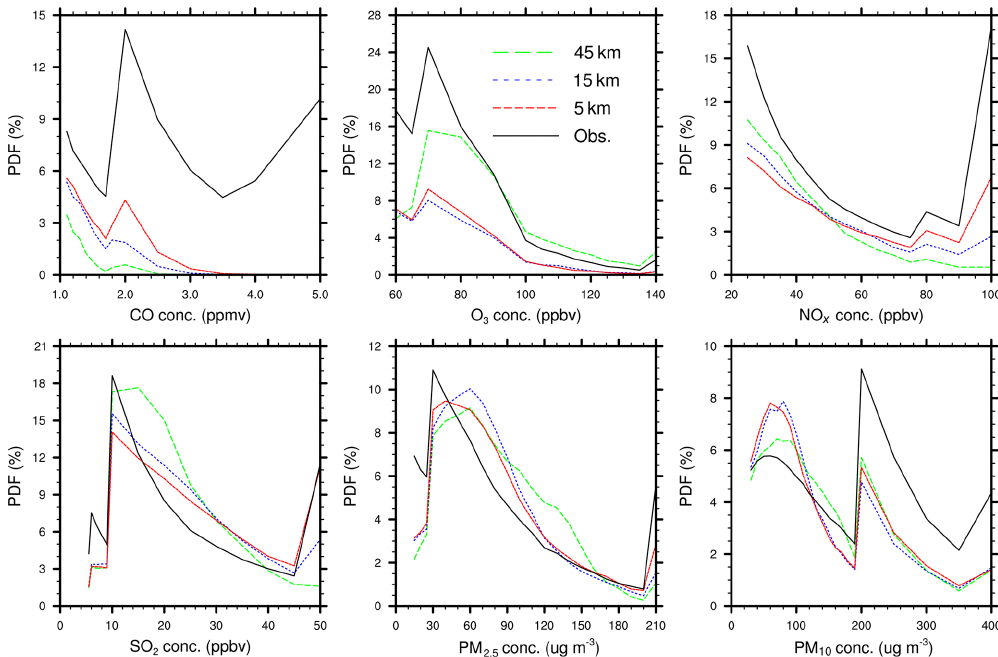
Figure 5. Probability density function (PDF) plots for hourly concentrations of surface air quality for the year of